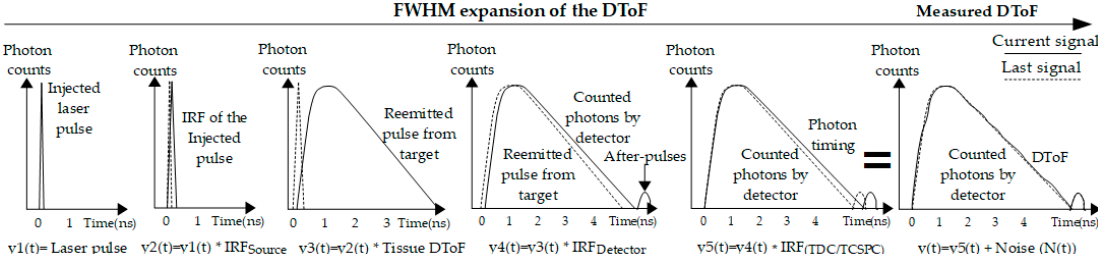
Figure 6. Broaden of measured DToF. Main contributions of the broadening are the time of flight of photons in a turbid medium; noise of the prototype; and the IRF of laser source, detector, and TDC/TCSPC.